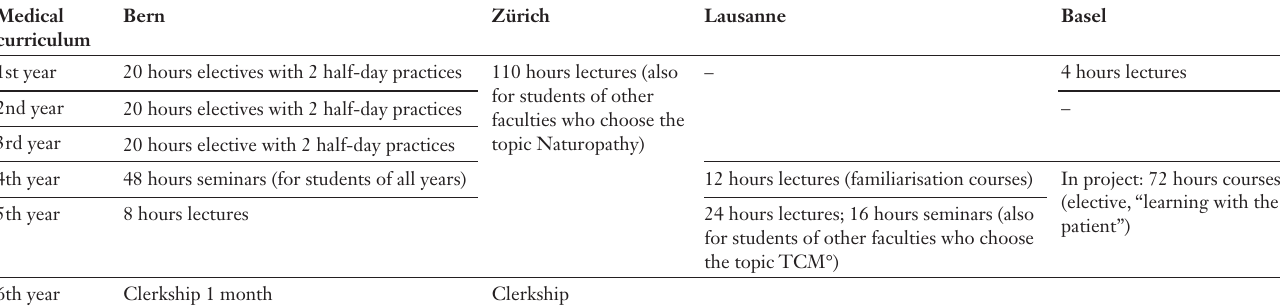
Structure of CAM courses at Swiss Medical Schools* in hours per